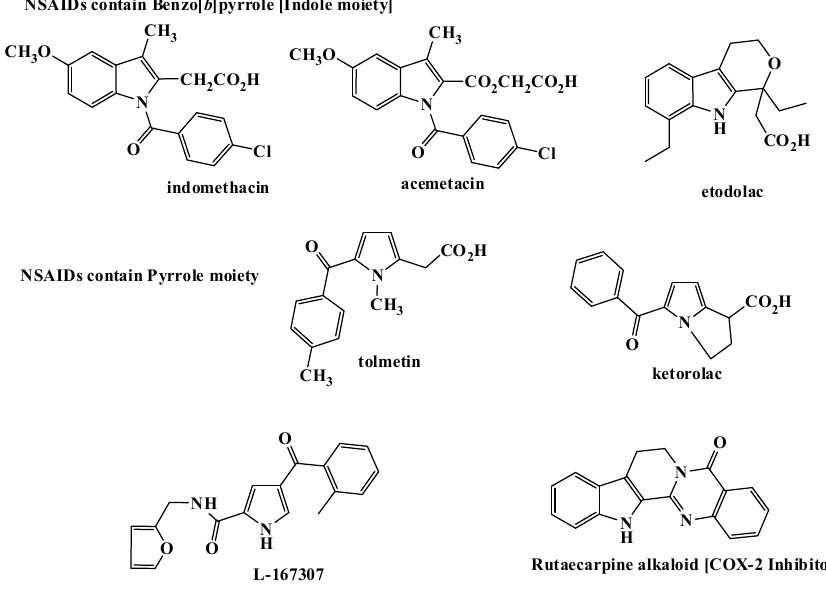
Figure 1. NSAIDS containing pyrroles moiety.